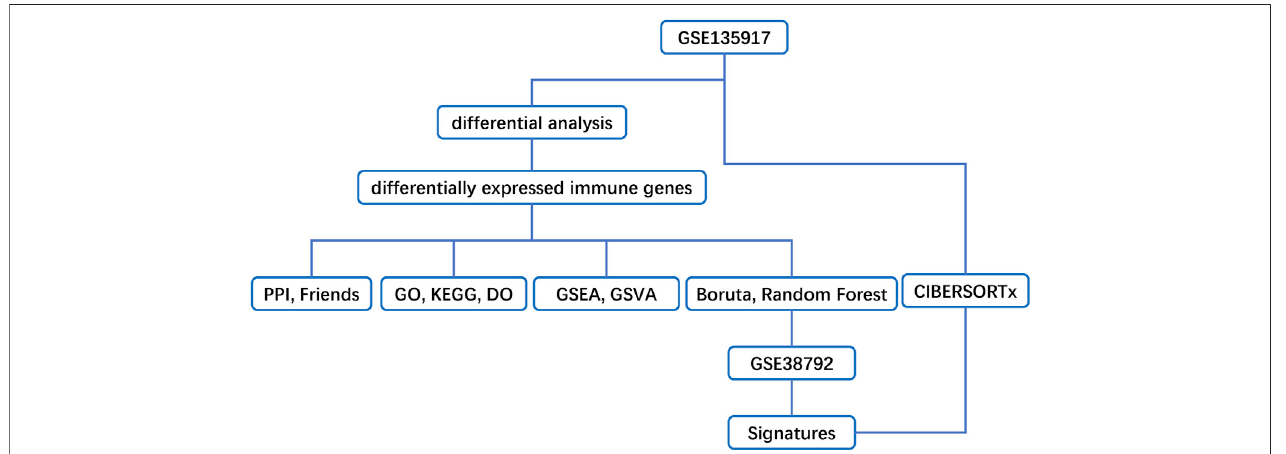
FIGURE 1 | Flow chart of methodologies applied in the current